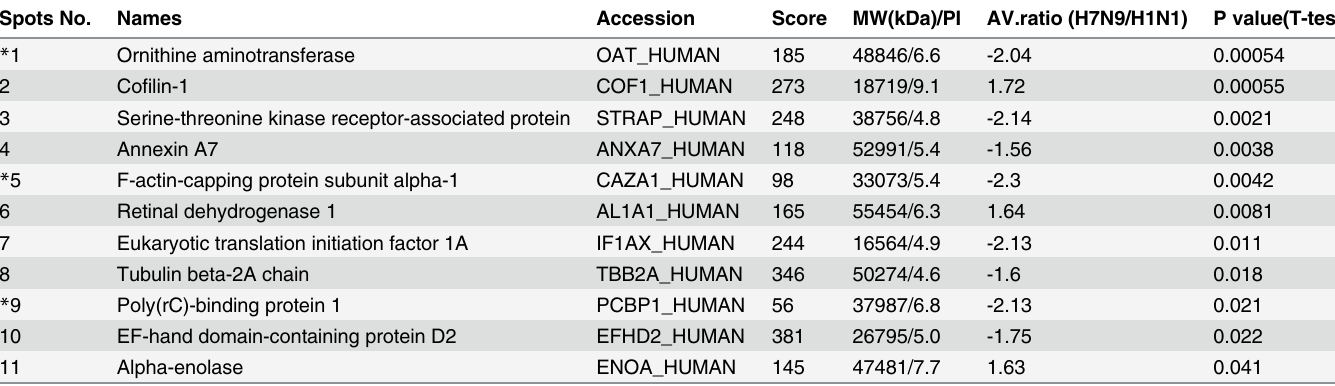
Table 1. Identification of differentially expressed proteins in A549 cells infected with H7N9 and H1N1pdm09 influenza virus at 24hpi. Spots No.